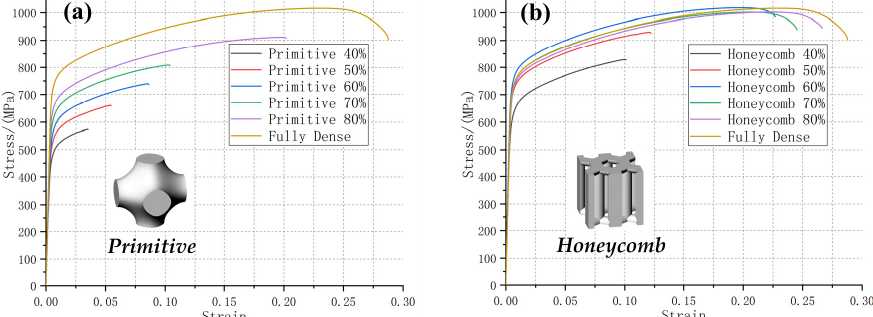
Figure 6. The stress-strain curves of ( a ) the primitive TPMS porous test specimen and ( b ) the honeycomb metal lattice test specimen, all with 40–80% relative densities. The corresponding geometric model of the unit cell is provided. The stress-strain curve of the original test specimen was used as a reference.